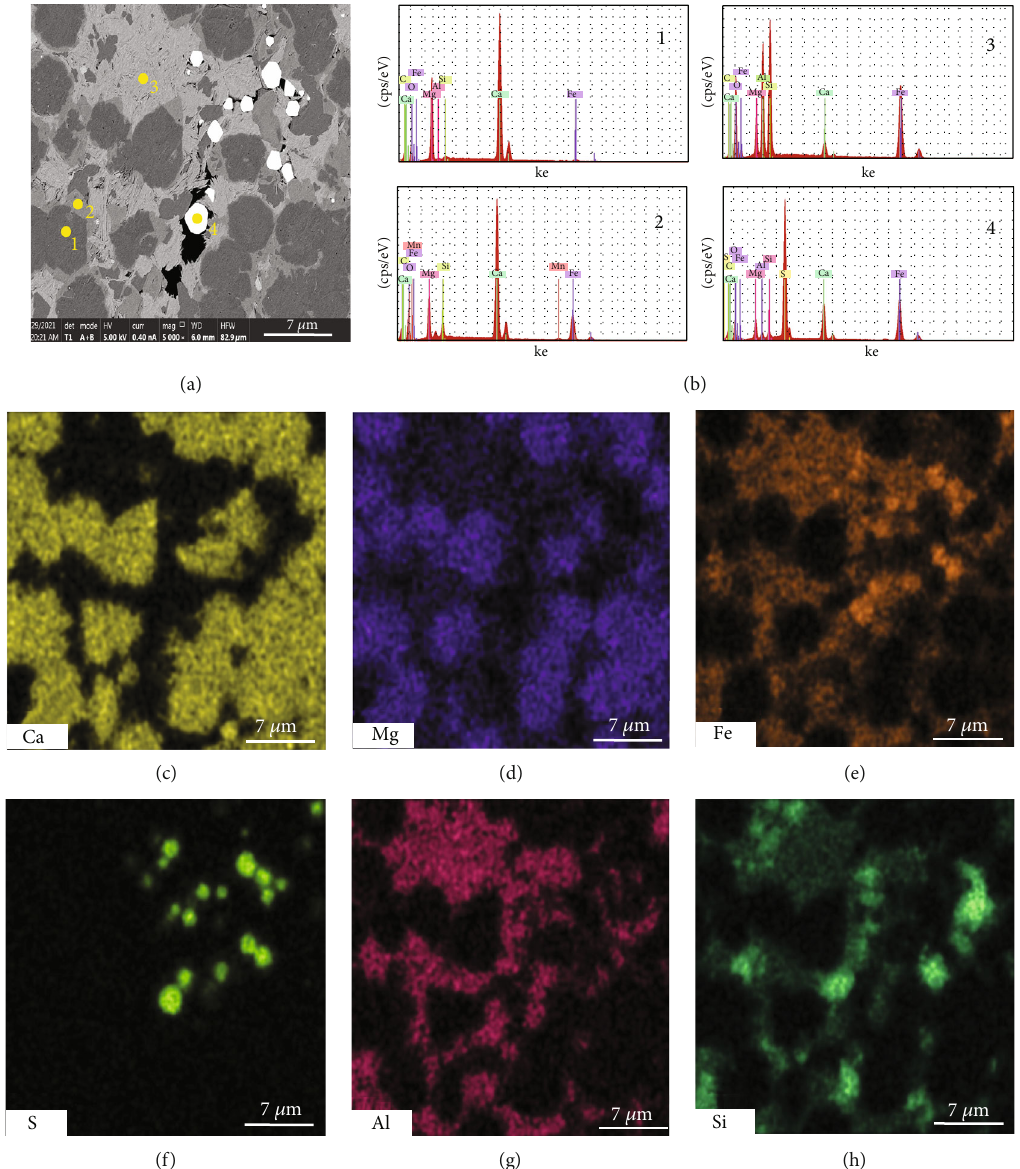
Figure 4: SEM image (a) and the corresponding EDX elemental mappings (c – h) of the rim part in dolomite nodule. The EDX spectra of points 1-4 in (a) are shown in (b), which indicate dolomite (1), ankerite (2), chlorite (3), and pyrite (4),